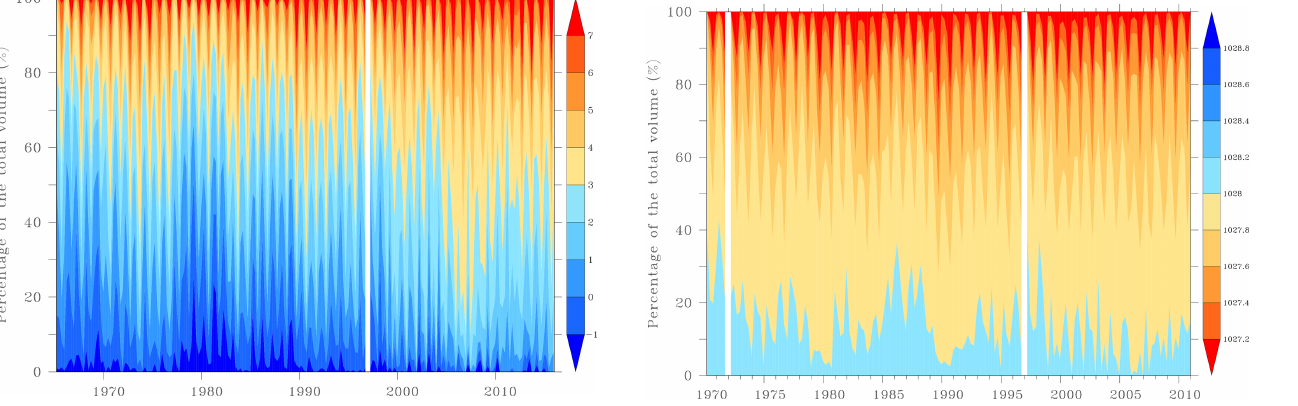
Figure 12. Volumetric potential density classes ranging from 1027.2 to 1028.8kgm − 3 in the most reliable area per season be- tween 1970 and